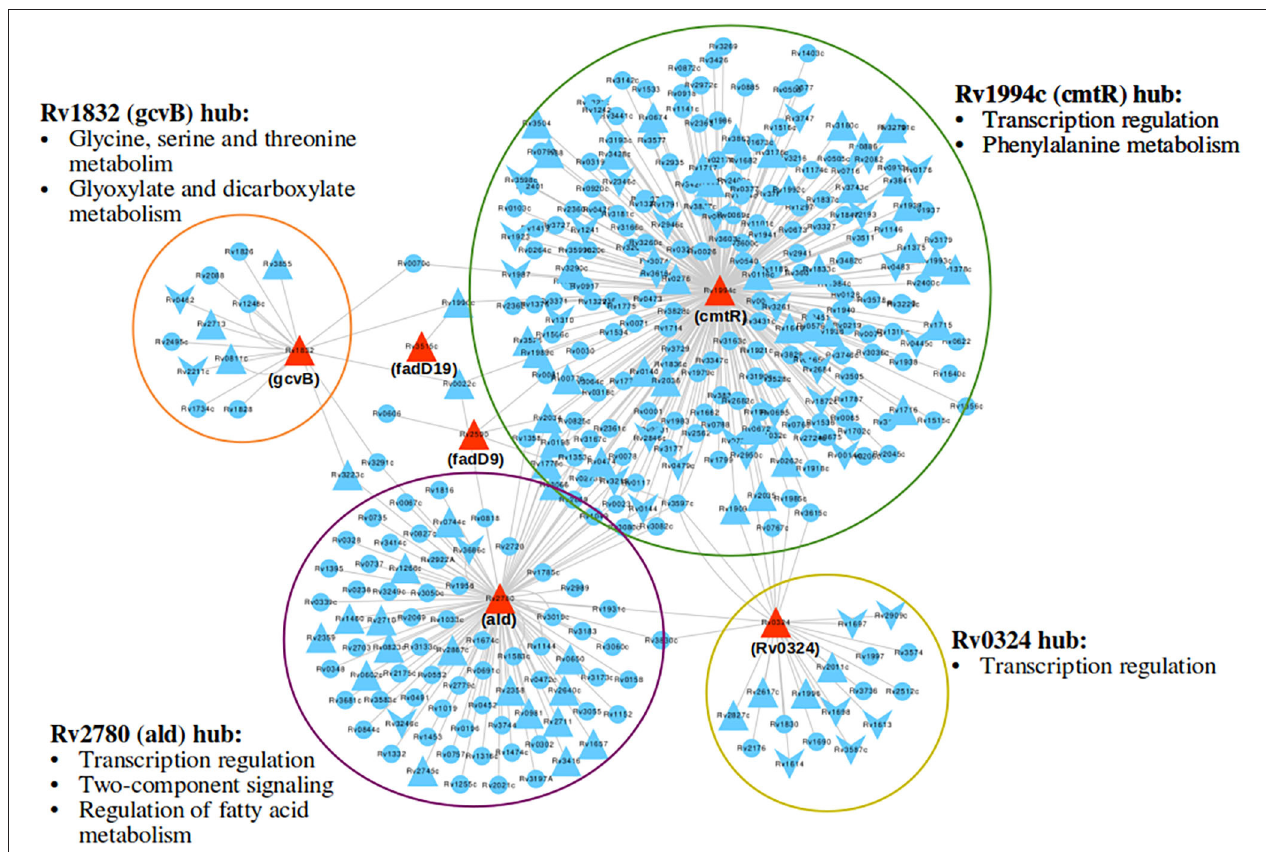
FIGURE 4 | A subnetwork of union dormancy response network for the 6 shortlisted drug target candidates and their first neighbors. The target candidates are colored in red. Upward and downward triangular nodes signify up and downregulation of gene expression, respectively. cmtR (Rv1994c) is the biggest hub in the network, followed by ald (Rv2780). Most over-represented pathways among the first neighbors of each of the hubs are mentioned.